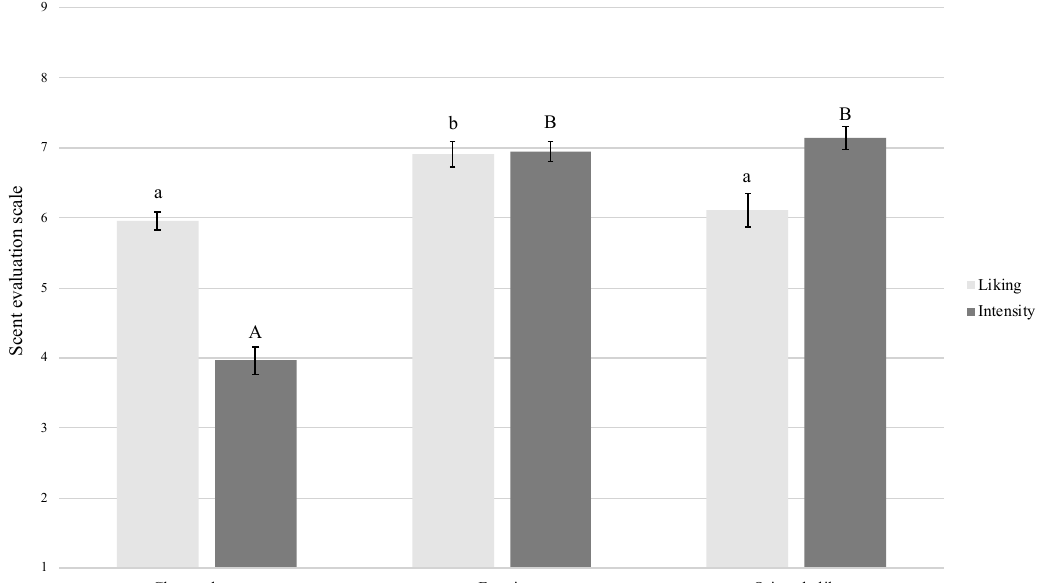
Figure 2. Floral scent liking and intensity of chrysanthemum, freesia, and oriental lily, evaluated through sensorial analysis (±SE, n = 80). The scale ranged from ‘like extremely/extremely high’ (= 9) to ‘dislike extremely/extremely low’ (= 1). Different letters (small = liking, capital = intensity) indicate significant differences in ANOVA followed by a Tukey’s post hoc test ( p ≤ 0.05).